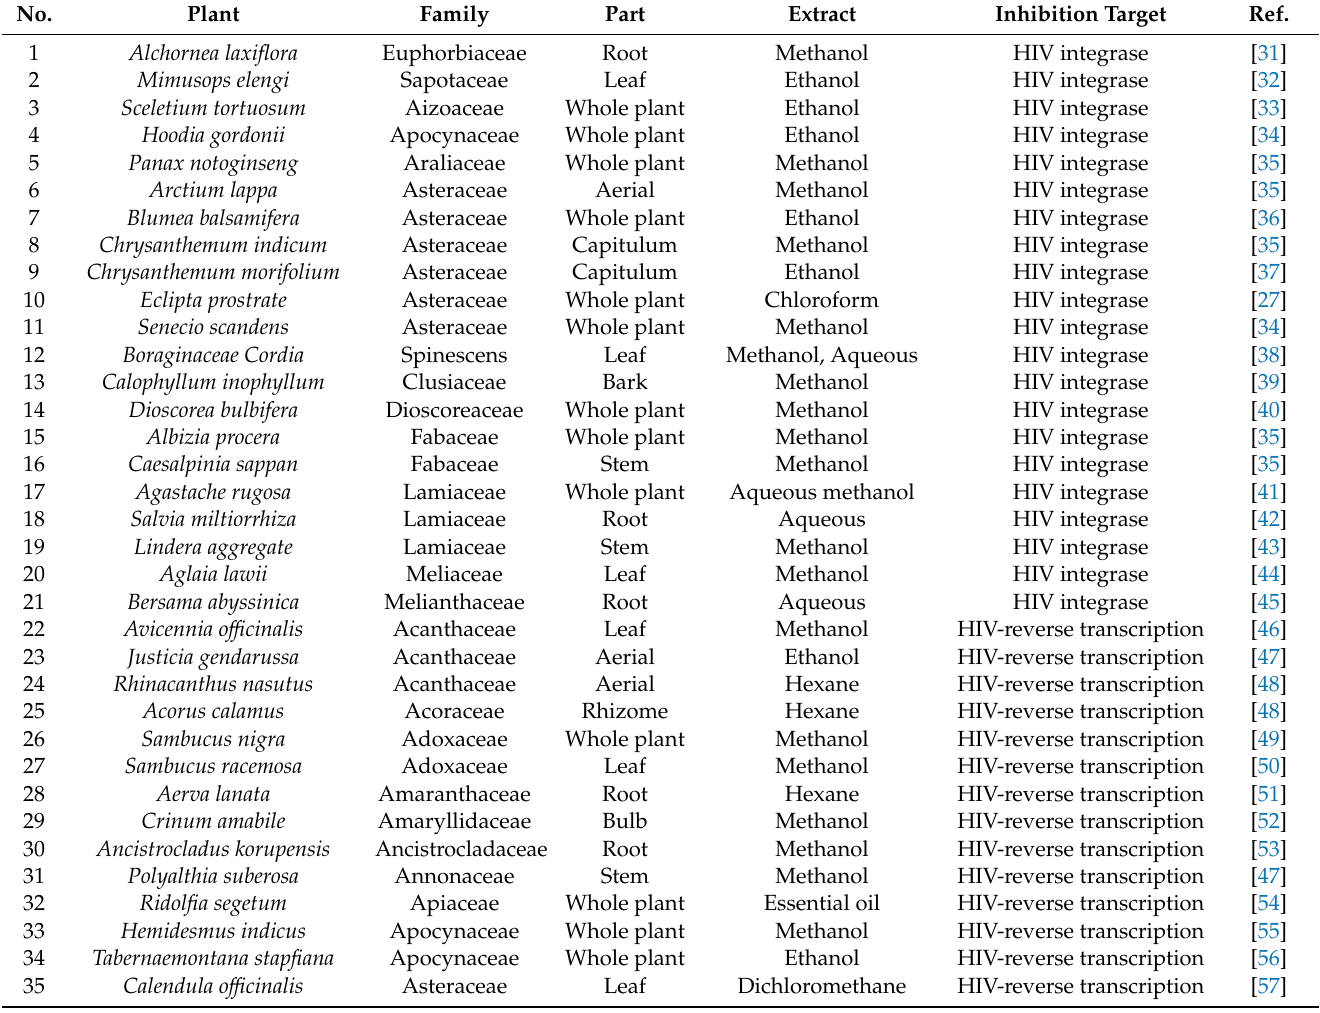
Table 1. Review of the plants that have shown anti-HIV activities with their prospective family, part, type of extract, and inhibition target. No.